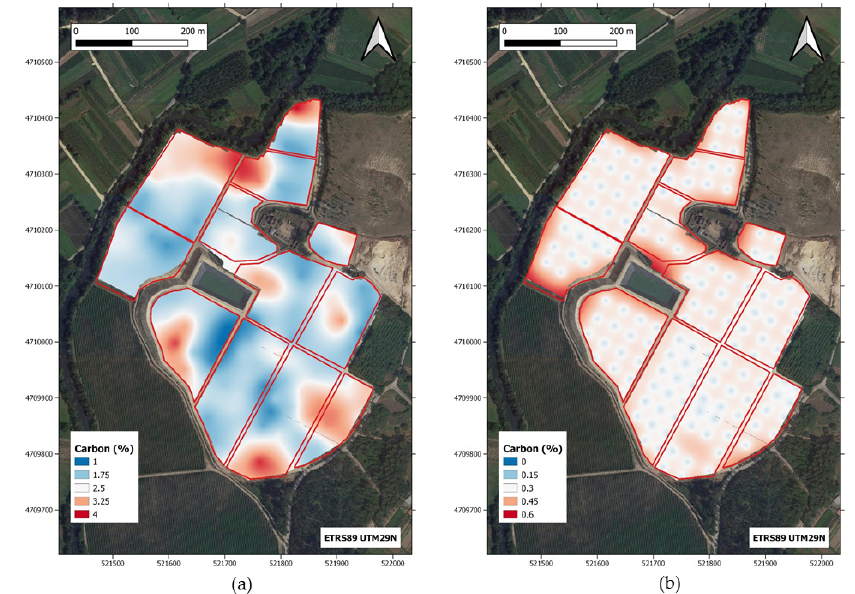
Figure 6. Estimation ( a ) and error ( b ) maps of soil C content over the experimental vineyard generated by ordinary kriging. by ordinary